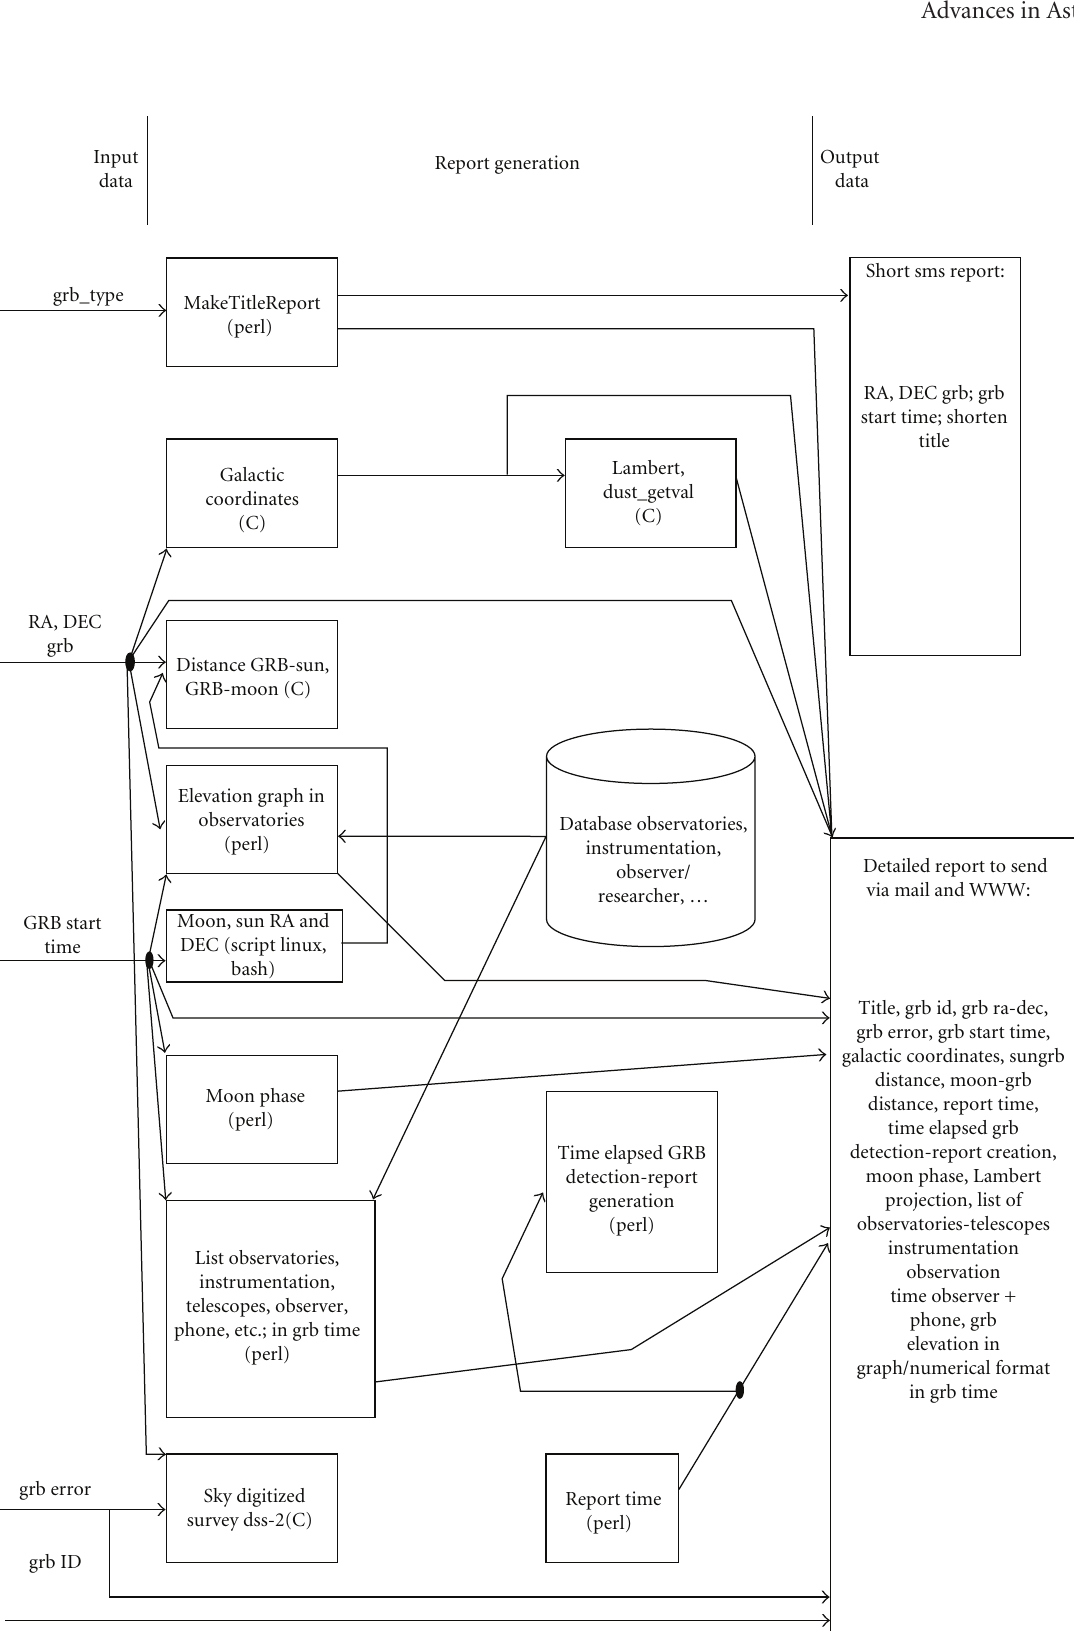
Figure 3: Detailed operation of the